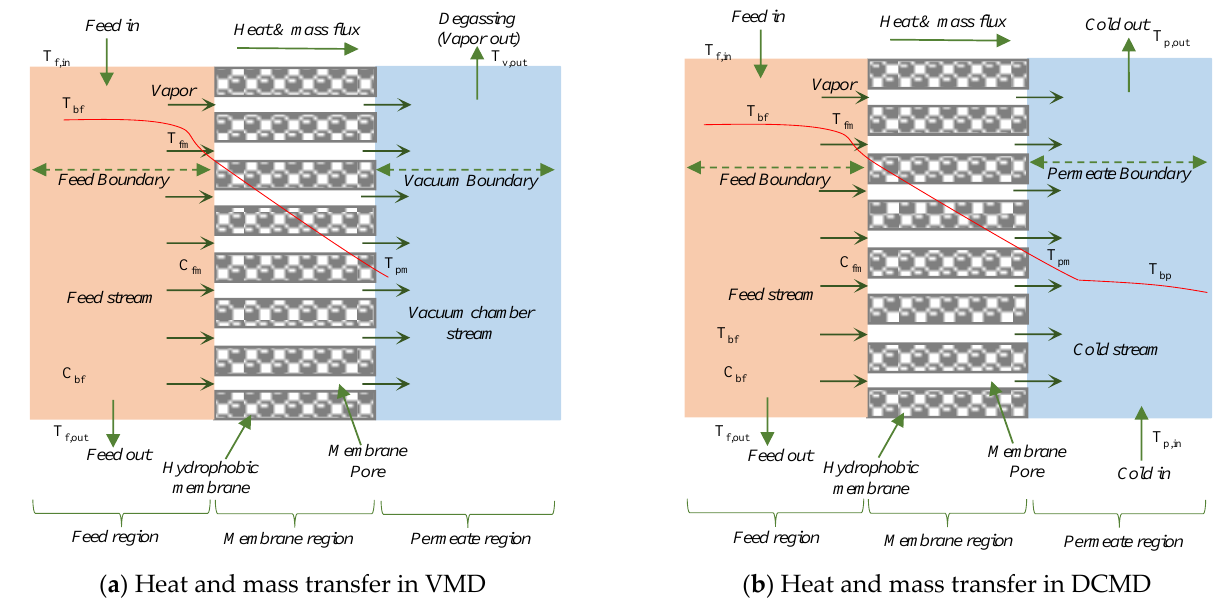
Figure 3. Heat and mass transfer in VMD and DCMD